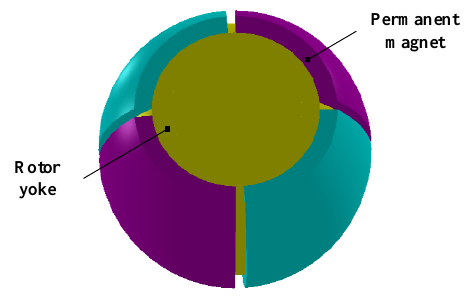
Figure 29. Three-dimensional model of the rotor.